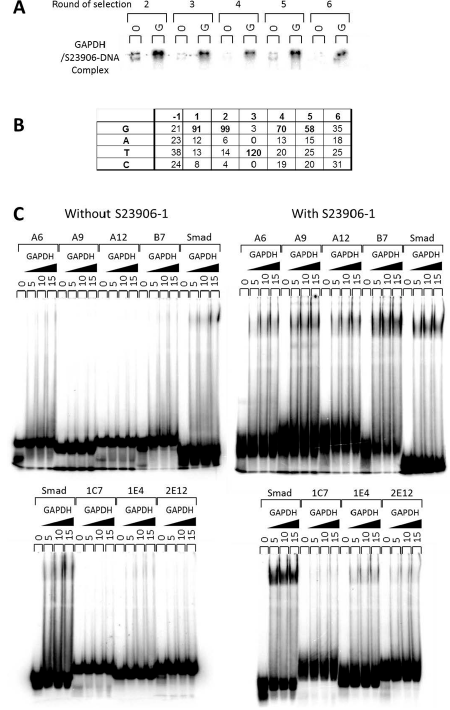
Figure 5. Binding of glyceraldehyde-3-phosphate dehydrogenase (GAPDH) to S23906-1 DNA adducts. ( A ) Increased selectivity for adduct recognition in the course of binding site selection is visualized upon migration of the radiolabeled mixture of DNA with GAPDH (5 μ g) on a native 6% polyacrylamide gel. “0” and “G” refer to the absence or presence of GAPDH proteins; ( B ) Determination of the preferential binding site upon alignment of the amplified sequences; ( C ) EMSAs evidence a differential complexation efficiency of GAPDH on S23906-1 alkylated (labeled “with S23906-1”) or unalkylated (labeled “without S23906-1”) using various DNA sequences from [176] and comparison with the reference DNA Smad-SBE (Smad).